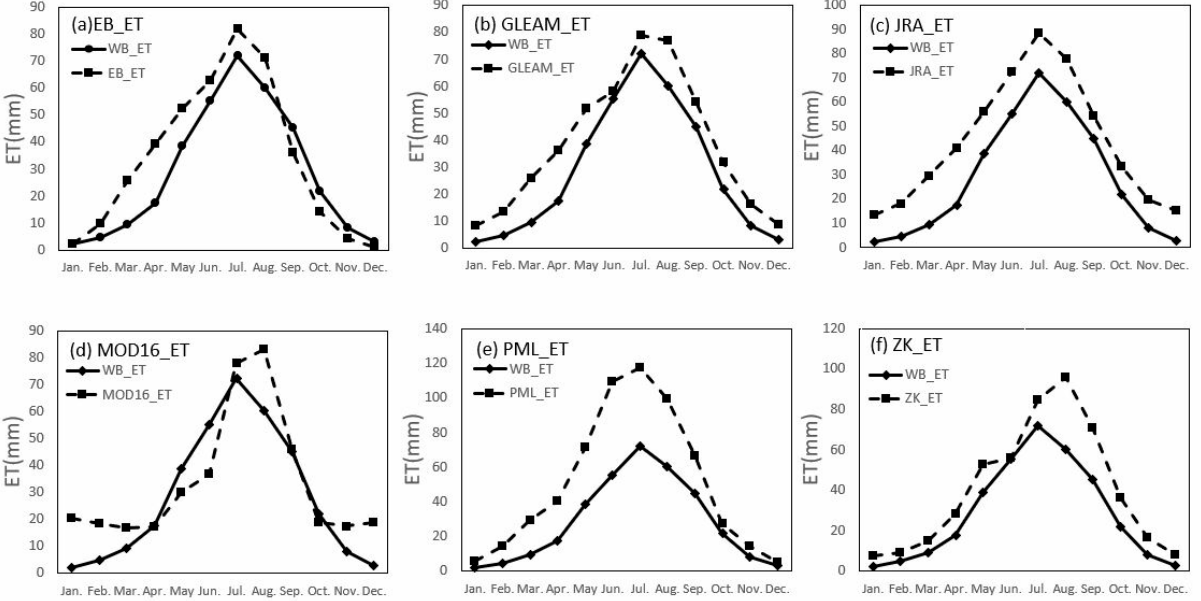
Figure 7. Comparison of multi-year averaged monthly evapotranspiration of the WB_ET and the different products from 2003 to 2012.